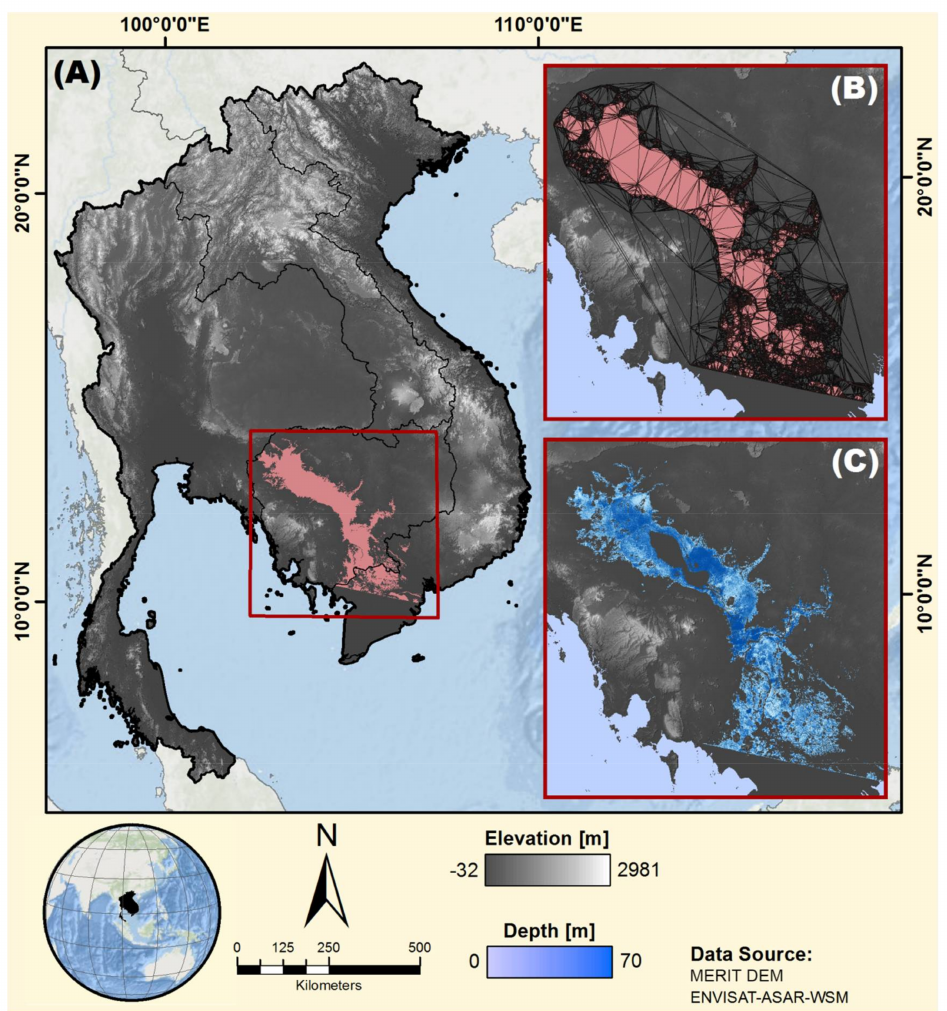
Figure 1. ( A ) Map of Mekong River Basin countries with flood extent from 2011 event. ( B ) Study extent showing results of the triangular interpolated network (TIN). ( C ) Depth raster produced by inundation depth